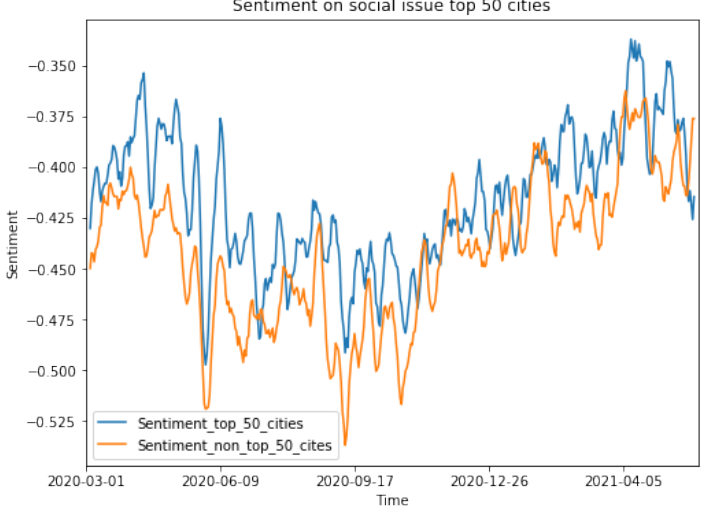
Figure 11. Sentiments towards social issues: top 50 cities vs. the rest of the